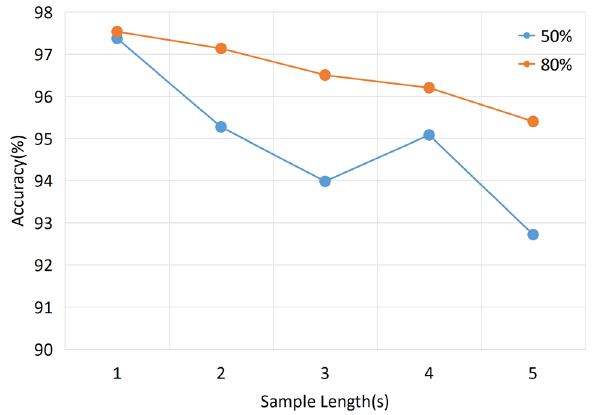
Figure 3. Results of the ETST model in different segment length and